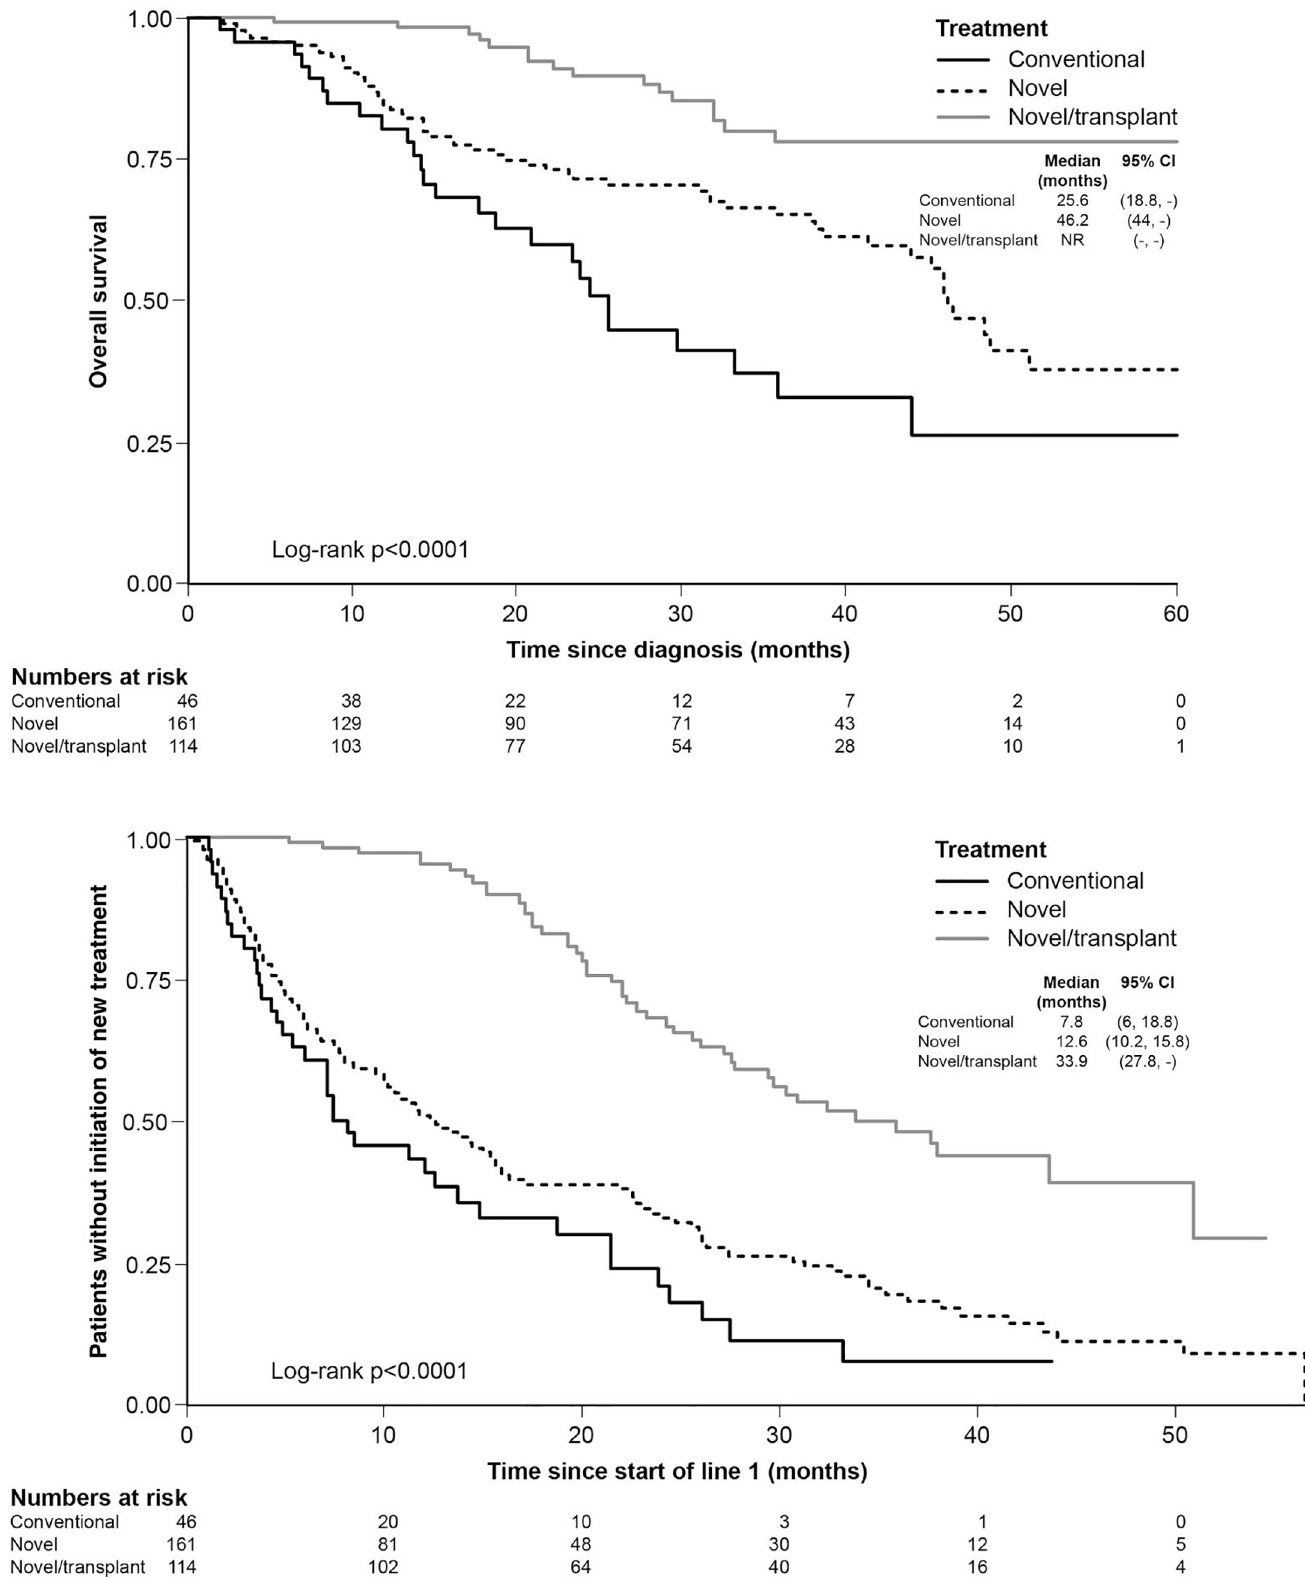
Fig 2. OS (top) and TTNT (bottom) by first-line treatment choice (transplant and non-transplant patients). https://doi.org/10.1371/journal.pone.0208507.g002 PLOS ONE | https://doi.org/10.1371/journal.pone.0208507 December5,